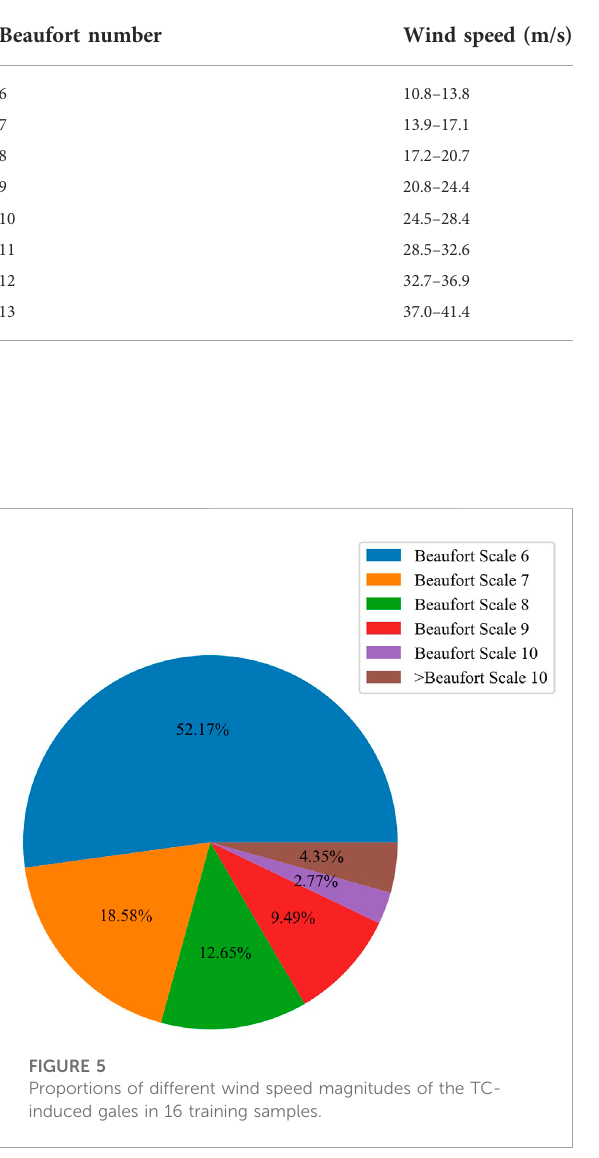
TABLE 3 Beaufort scale of wind speeds.